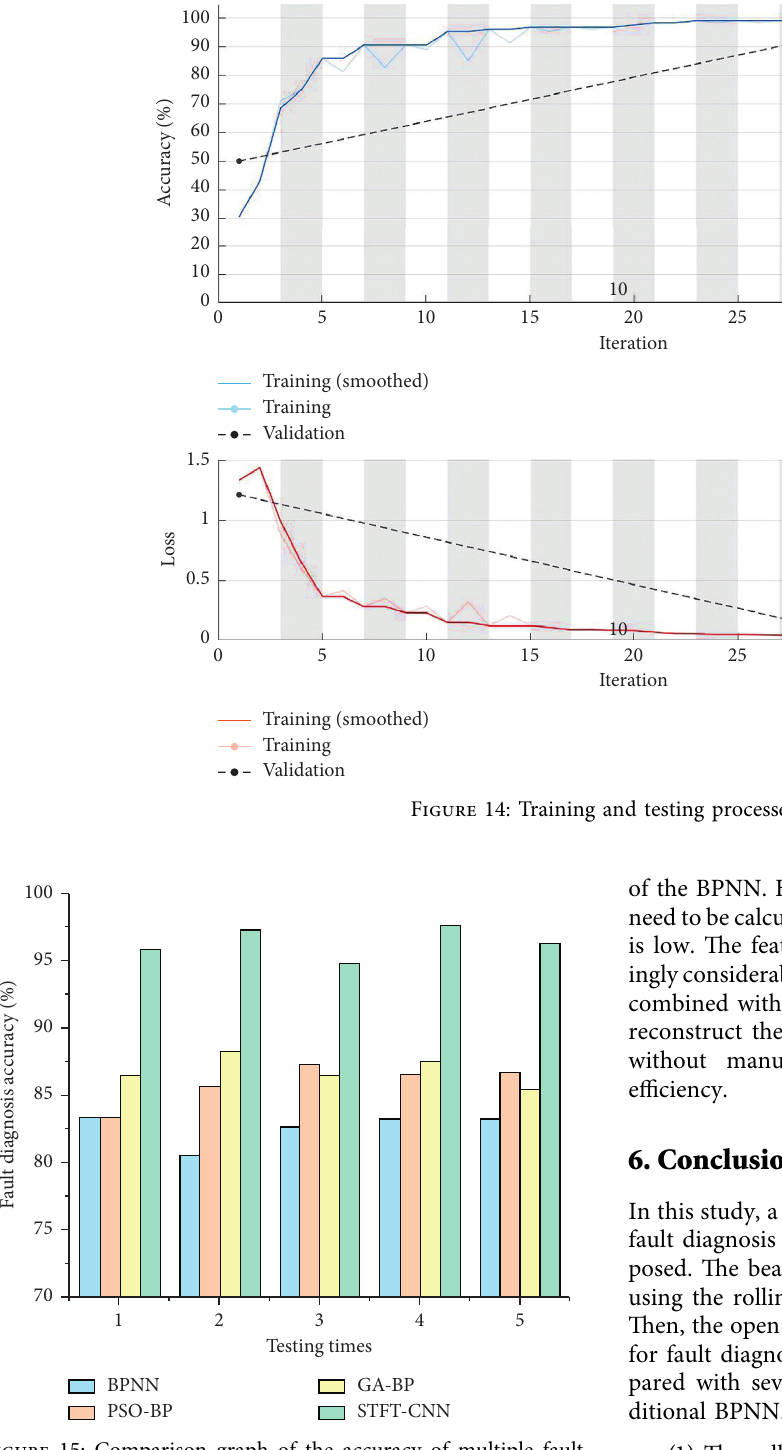
Figure 15: Comparison graph of the accuracy of multiple fault diagnosis